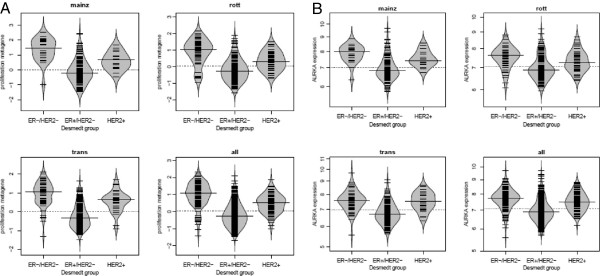
Beanplots showing expression levels of AURKA (A) and the proliferation metagene (B) in the three different molecular subtypes of breast cancer in each individual subcohort (Mainz, Rotterdam and Transbig) and in the combined cohort (all). The small lines represent the data points. The median is represented by a longer line.